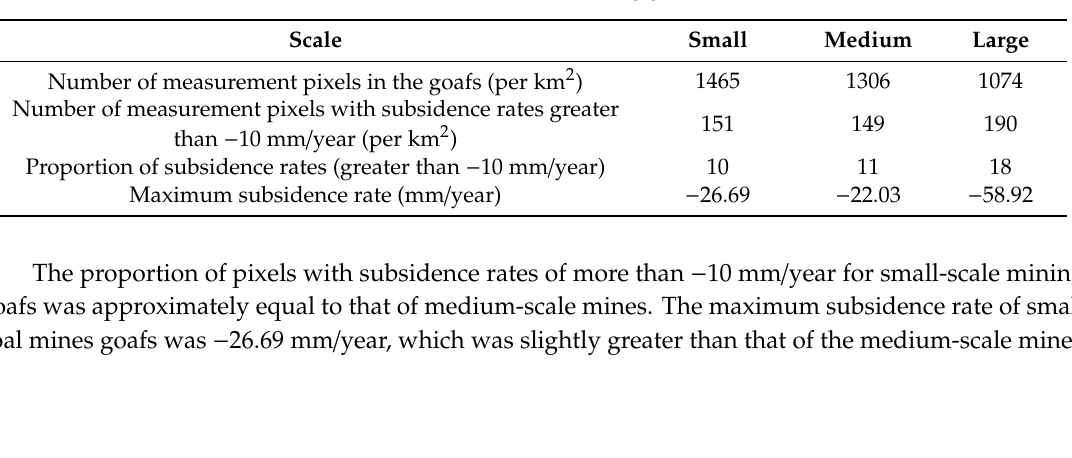
Table 4. Statistics of three scales of coal mining goafs from 2006 to 2011. Scale Small Medium Large Number of measurement pixels in the goafs (per km 2 )